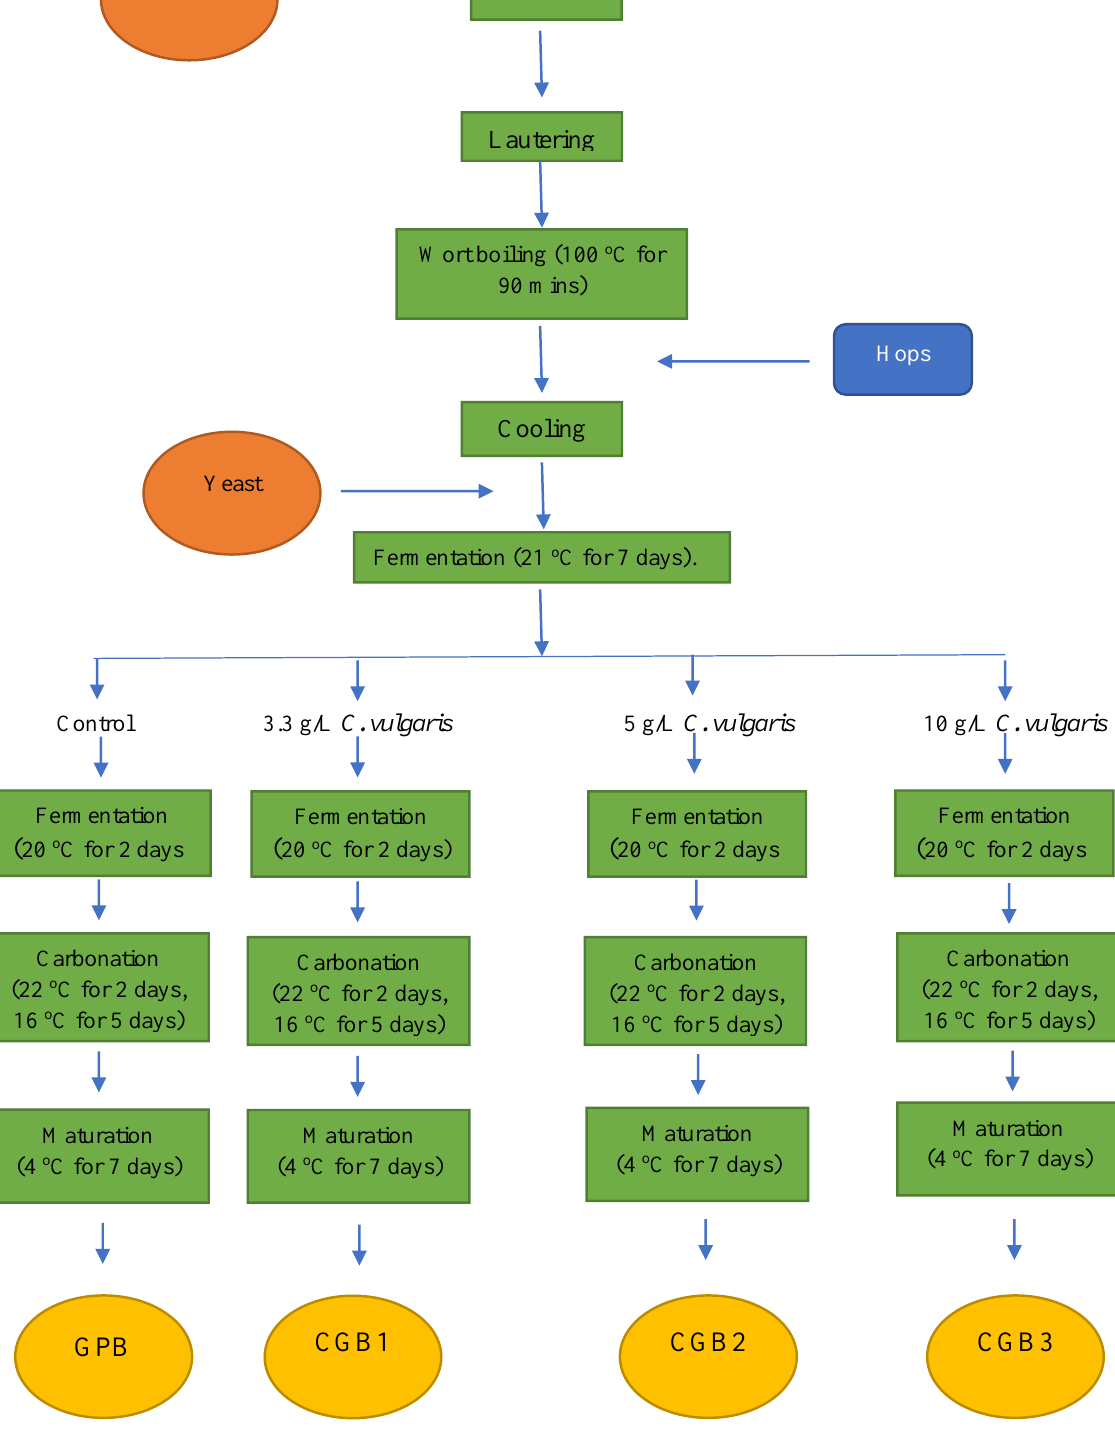
Figure 1. Flow chart of Chlorella vulgaris- enriched beer production.